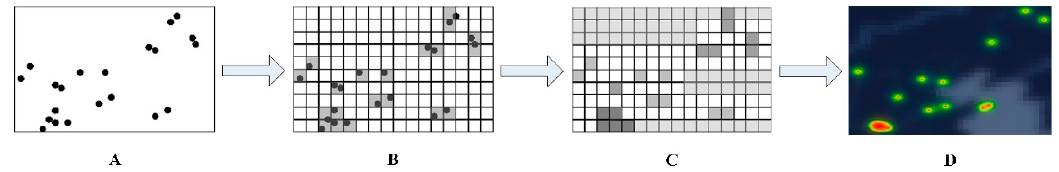
Figure 6. Schematic diagram of the generation process.